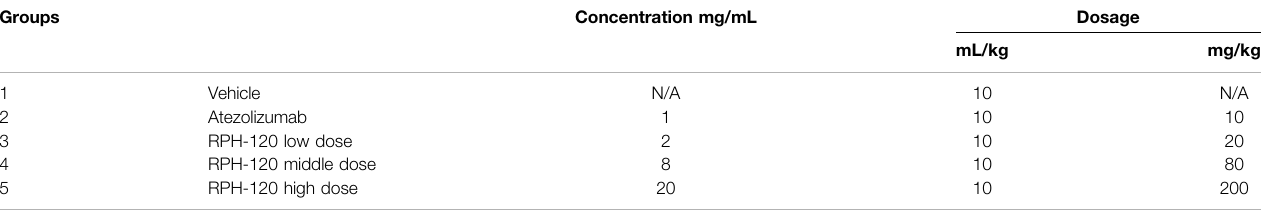
TABLE 1 | Grouping and dosing regimen in the in vivo ef fi cacy experiment. Groups